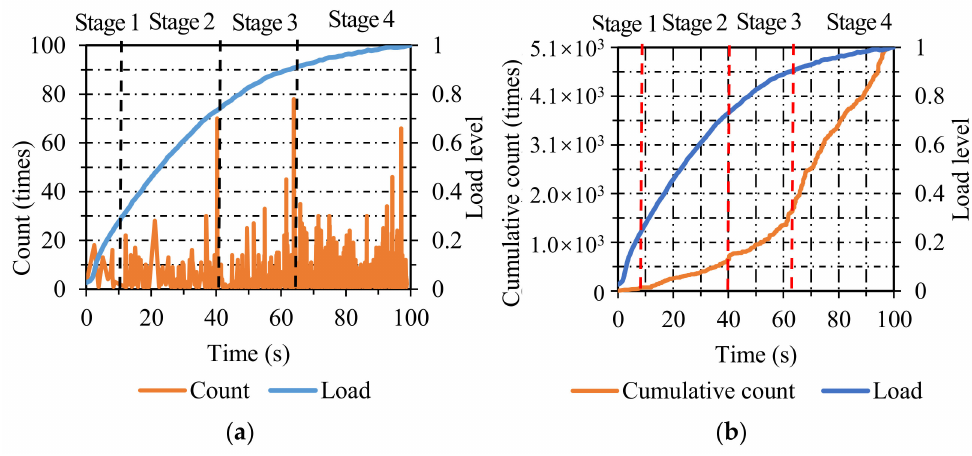
Figure 9. The count and cumulative count distribution of OGFC: ( a ) count; ( b ) cumulative